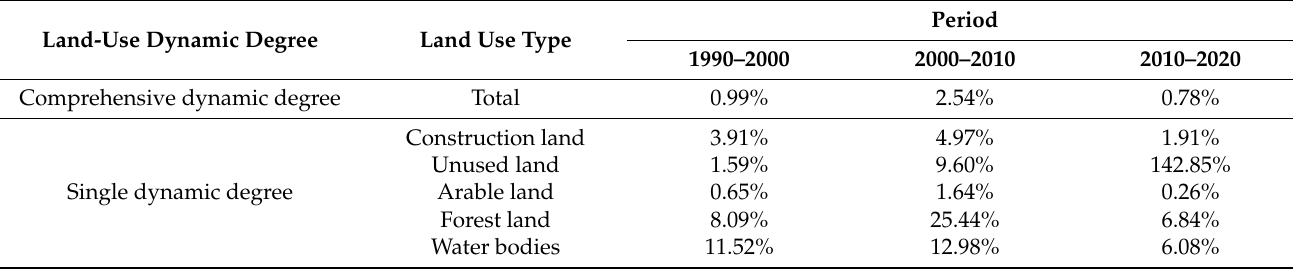
Table 1. Land-use dynamic degree in the TWL region